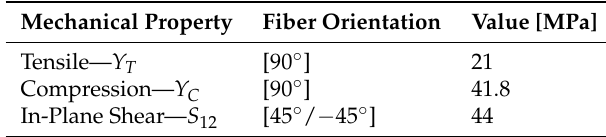
Table 3. Experimental data for 3D-printed continuous carbon fiber reinforced thermoplastic lamina [35,40]. Mechanical Property Fiber Orientation Value [MPa]